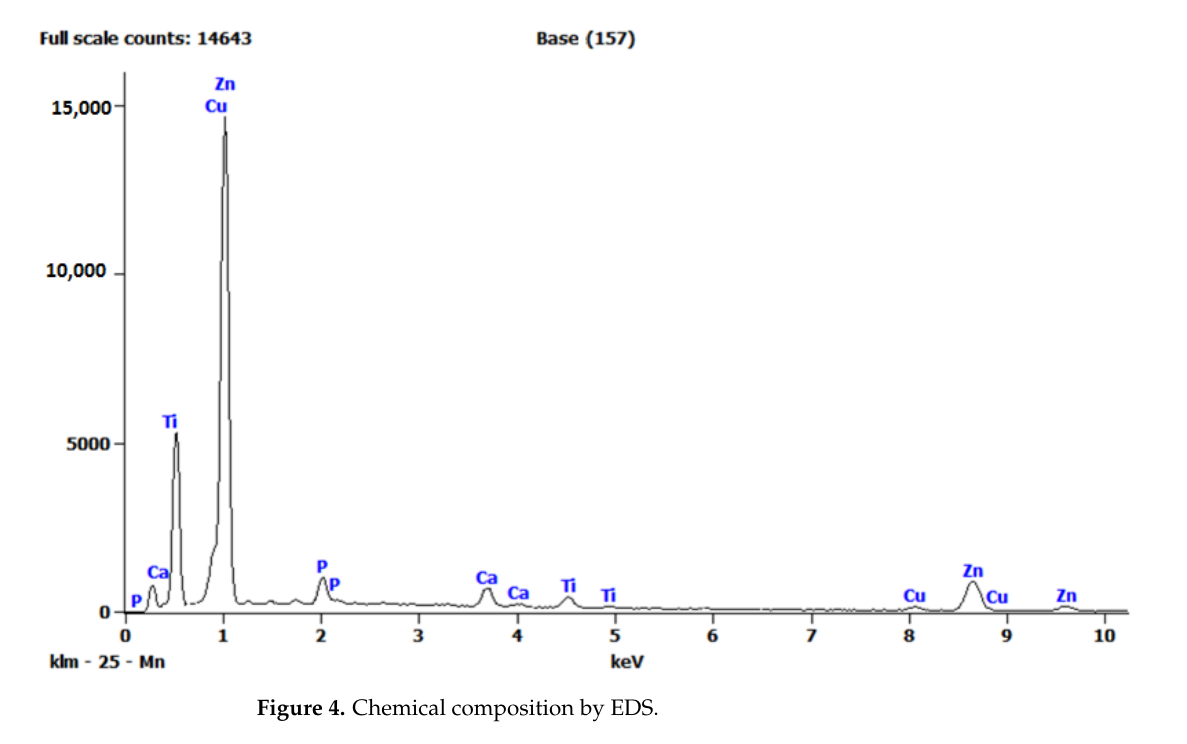
Figure 3. XRD: biodegradable zinc alloy.